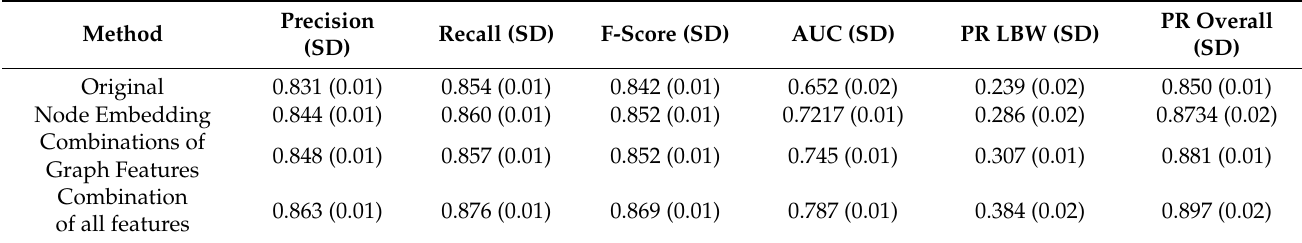
Table 7. Experiments performed using the MLP